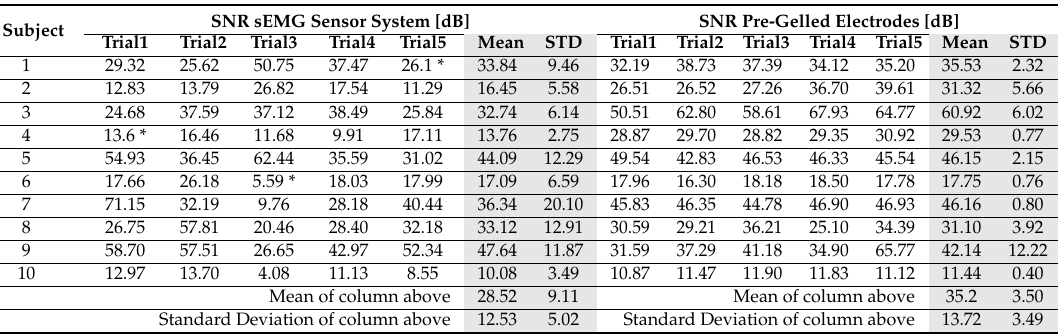
Table A3. Comparison between the signal-to-noise ratio (SNR) of the signal of the first relevant channel detected with the sEMG sensor system and the SNR of a sEMG signal detected using a commercial sEMG system based on pre-gelled electrodes. Electrode placements and signal processing complied with the SENIAM